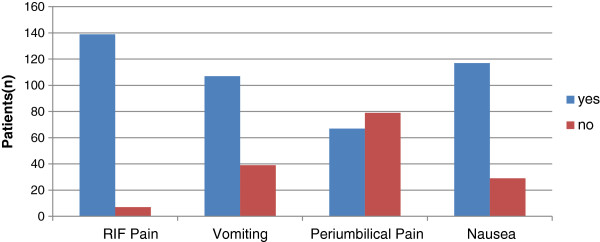
Signs and symptoms.